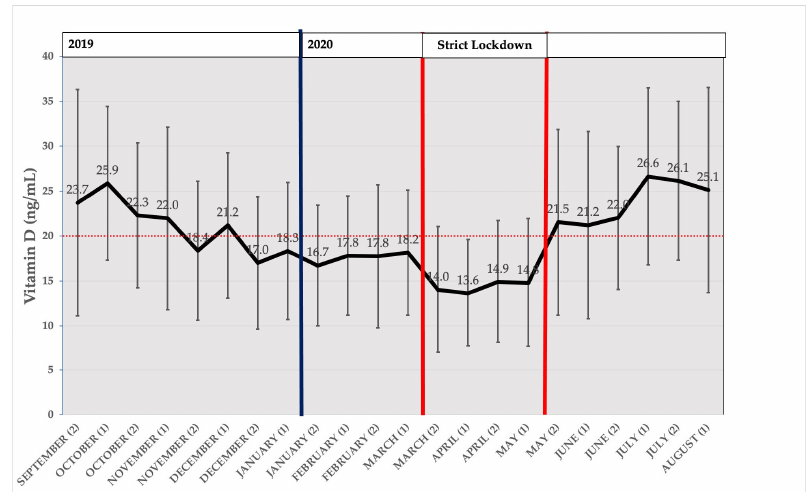
Figure 2. Distribution of vitamin D Levels (ng/mL) by fortnight from mid-September 2019 to mid- August 2020, expressed as mean 25(OH)D (in ng/mL) of all participants by biweekly intervals. Bars represent 95%CI. Dark blue vertical line represents the beginning of year 2020. Red bold vertical lines represent the beginning and the end of strict lockdown. The horizontal red dotted line represents the threshold for VDD diagnosis (20 ng/mL).